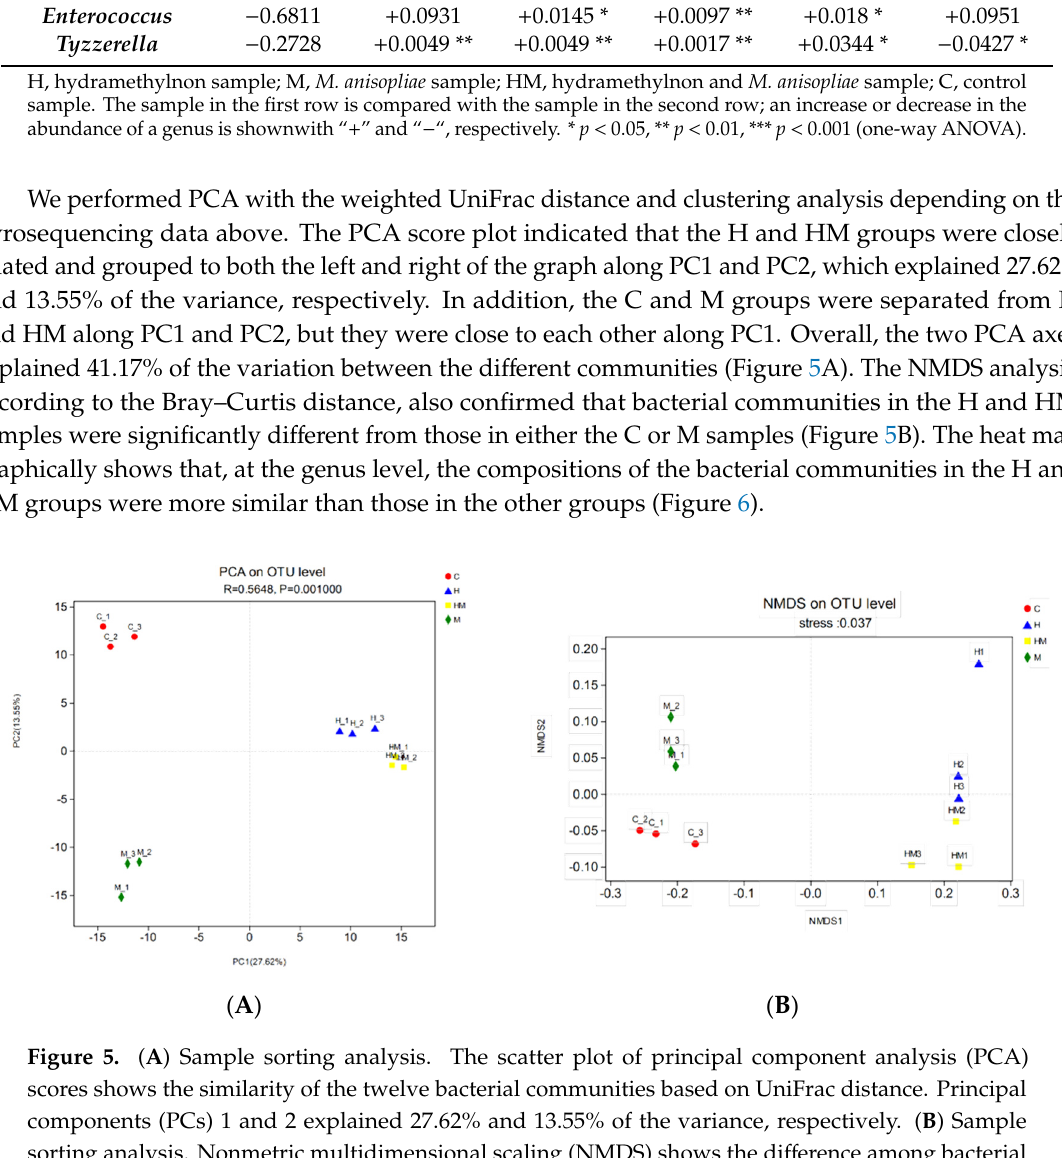
Figure 6. Heatmap of the top 50 most abundant genera in the bacterial communities detected in the 16 samples. Dendrograms for hierarchical cluster analysis grouping genera and sample locations are shown at the left and at the top, respectively. The color scale represents the normalized values of relative abundances transformed by log 10 . Zero values were added as 1 and log 10 transformed. H, hydramethylnon sample; M, M. anisopliae sample; HM, hydramethylnon and M. anisopliae sample; C, control sample.